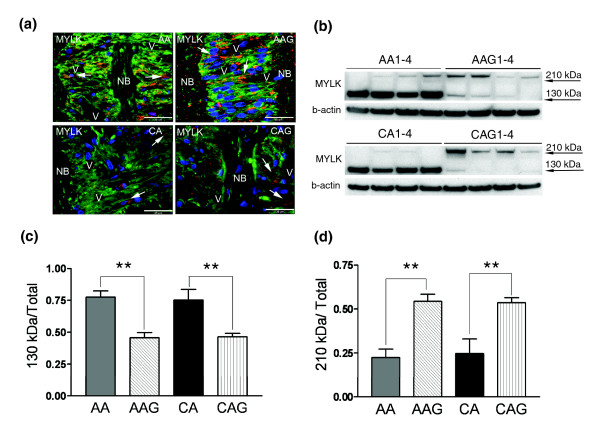
MYLK isoform expression in ONH astrocytes. (a) Representative double immunofluorescent staining of MYLK (red) and astrocyte marker GFAP (green) in sections of human ONH from an AA donor (51 year old male), AAG donor (70 year old male), CA donor (56 year old female) and CAG donor (76 year old male). Nuclei (blue) are stained with DAPI. Note strong granular staining of MYLK in astrocytes (arrows) in the cribriform plates of the lamina cribrosa of AA and AAG donors compared to CA and CAG donors. V, blood vessel; NB, nerve bundle. Scale bar 35 μm. (b) Representative western blots of astrocyte cell lysates with MYLK antibody. β-Actin was used as a loading control. Note that AAG1-4 donors express more MYLK-210 and less MYLK-130 than CAG1-4 donors. (c) Graph of MYLK-210 expressed as the fraction of MYLK-210 in the four groups. (d) Graph of the fraction of MYLK-130 expressed in the four groups. These results represent densitometry analysis of western blots using seven AA, five AAG, eight CA and eight CAG donor samples.